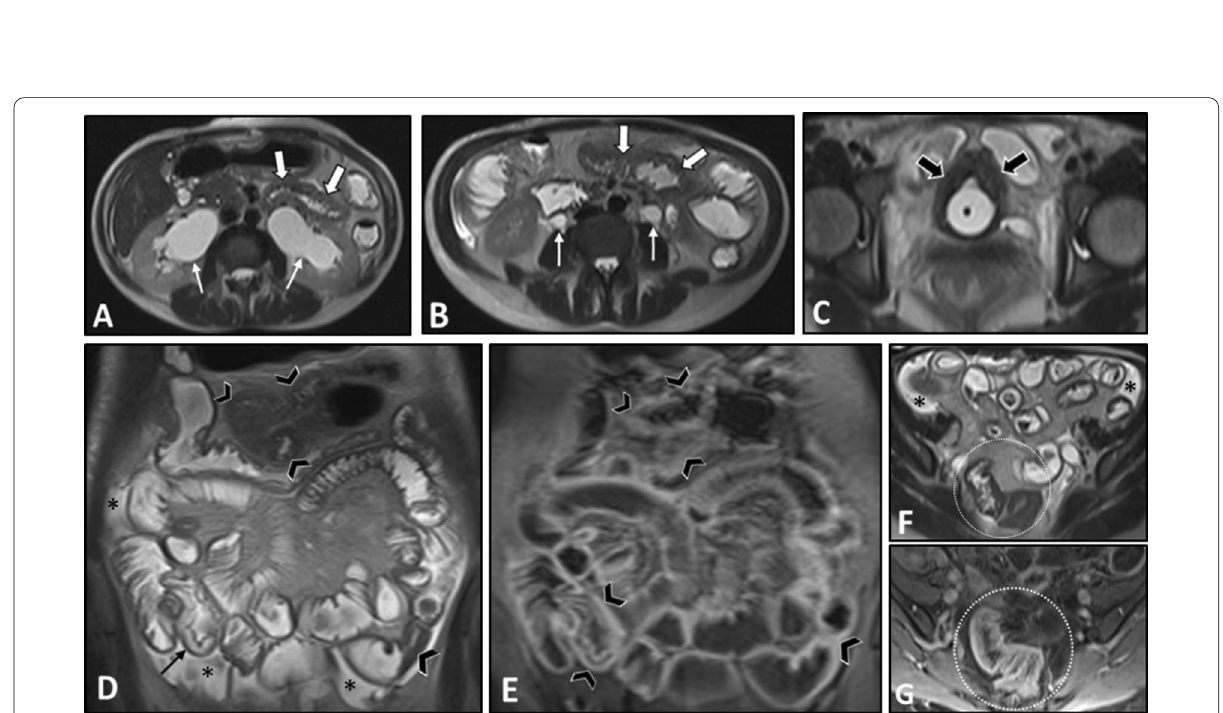
Fig. 15 Intestinal vasculitis in a 42-year-old female with a known history of SLE and hypothyroidism presenting with generalized abdominal pain, fever, anemia, and elevated inflammatory markers. She also complained of dysuria, hematuria, and frequency. MRE was obtained. Axial T2-W images ( A , B ) show bilateral hydroureteronephrosis (thin white arrows) and multi-focal segmental circumferential mural thickening involving several jejunal and ileal loops (thick white arrows). Axial T2-W image ( C ) displays an under distended urinary bladder containing a Foley catheter showing diffuse wall thickening (thick black arrows). Coronal T2-W and post-contrast T1-W images ( D , E ) demonstrate multi-segmental mural thickening involving several jejunal and ileal loops showing increased enhancement due to active nature of inflammation (black arrowheads). Submucosal edema is also noted (thin black arrow). Axial T2-W and post-contrast T1-W images ( F , G ) also reveal involvement of rectosigmoid colon (white dotted ovals). Small amount of free fluid is noted at the abdominopelvic cavity (black